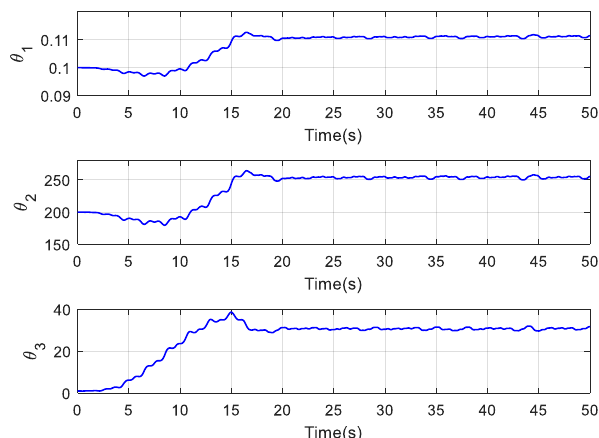
Figure 3. Parameter adaptation of FOFA.